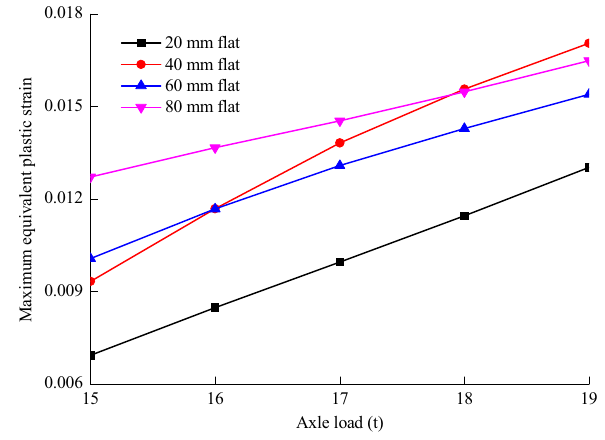
Fig. 14 Maximum equivalent plastic strain versus